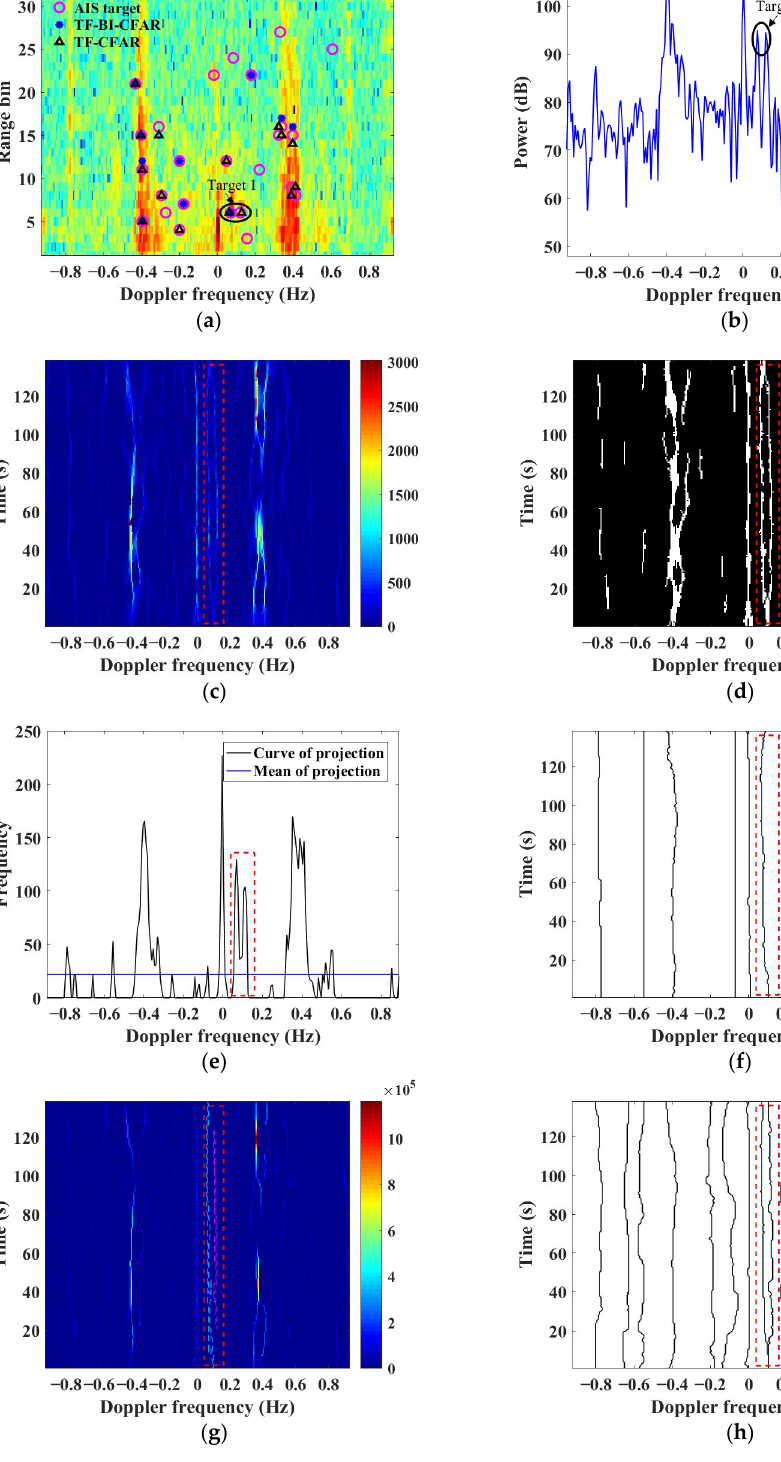
Figure 6. Comparison of multi-target by TF-BI-CFAR and TF-CFAR at 07:36 on 5 October 2015 and ( c – h ) are from TF-BI-CFAR and TF-CFAR, respectively. ( a ) target matching map on RD; ( b ) power spectrum at the 6th range bin; ( c ) SST image at the 6th range bin; ( d ) binary grayscale image of ( c ); ( e ) vertical projection of ( d ); ( f ) TF ridges extracted from ( c ); ( g ) TF ridges marked by Hessian matrix; ( h ) TF ridges extracted from ( g ). When the target is very close to the Bragg peaks, their TF ridges cannot be distin- guished by using the image binarization and projection method. In Figure 7a, Target 2 is located to the left of the positive Bragg peak and they are very close to each other. As can be seen from Figure 7c, the two TF ridges sometimes overlap along the time axis. After image binarization, the two TF ridges are aliased and cannot be distinguished in the grayscale image (see Figure 7d). After projection, the TF ridge of the clutter with the strongest energy is extracted as a target but the real target signal is missed (see Figure 7e,f). This case is similar to the case of multi-target. Likewise, Hessian matrix segmenta- tion can separate the two TF ridges in the TF plane, thus, successfully detecting the target signal (see Figure 7g,h).